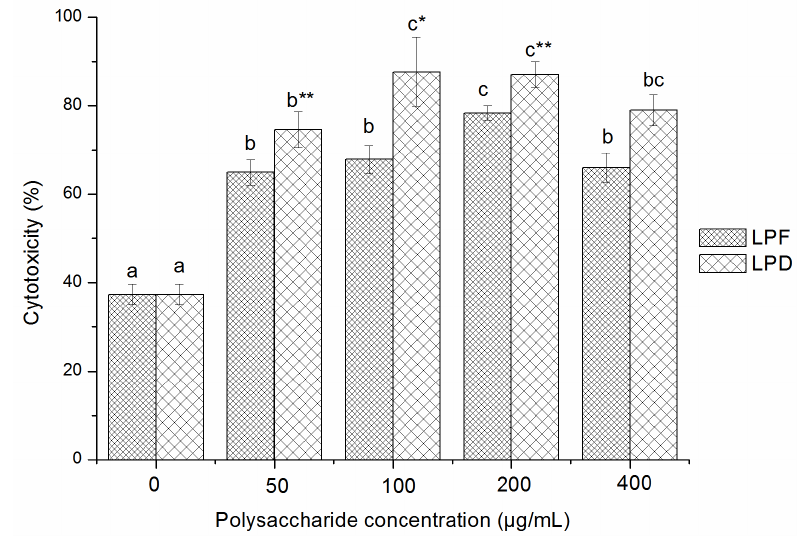
Figure 4. Cytotoxicity of NK cells stimulated by litchi polysaccharides LPF and LPD toward target cells. Cytotoxicity of NK cells was assessed by the MTT assay and expressed as the mean ± standard deviation ( n = 6). Bars labeled with different letters represent a statistical difference at p < 0.05 among different concentrations of the same sample.